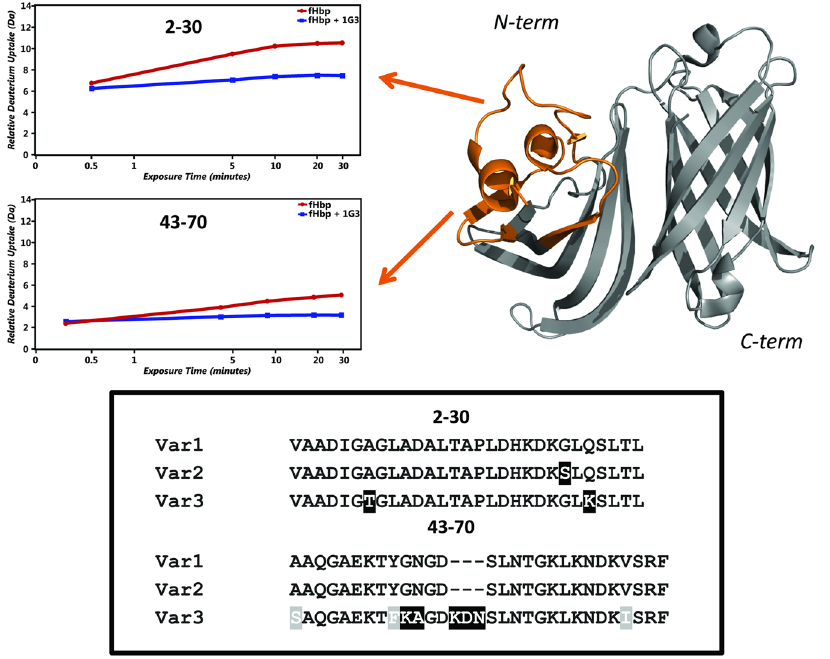
Figure 1. Epitope mapping by HDX-MS of the fHbp variant 1 region targeted by cross reactive mAb 1G3. ( a ) Two peptides show differential deuterium incorporation by HDX-MS, boxes show deuterium uptake over 30 minutes for fHbp peptides in the absence (red curve) or presence (blue curve) of mAb 1G3. ( b ) Multiple sequence alignment of the epitope peptides across variant 1, variant 2 and variant 3 fHbp. Residues that are conserved across all sequences are not highlighted. Residues highlighted in gray indicated conservative mutations and in black deletions and non-conservative mutations.